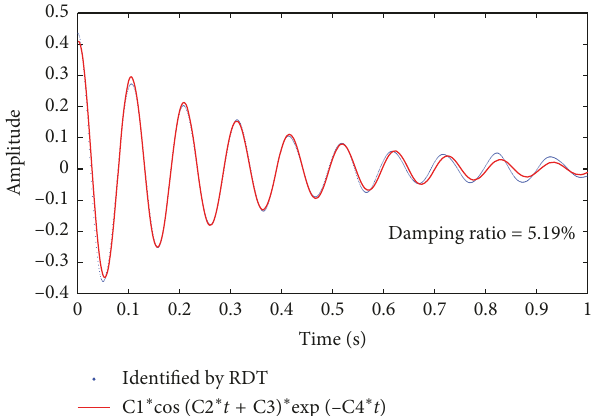
Figure 9: Identified process to obtain the first-order modal damping ratio [28].